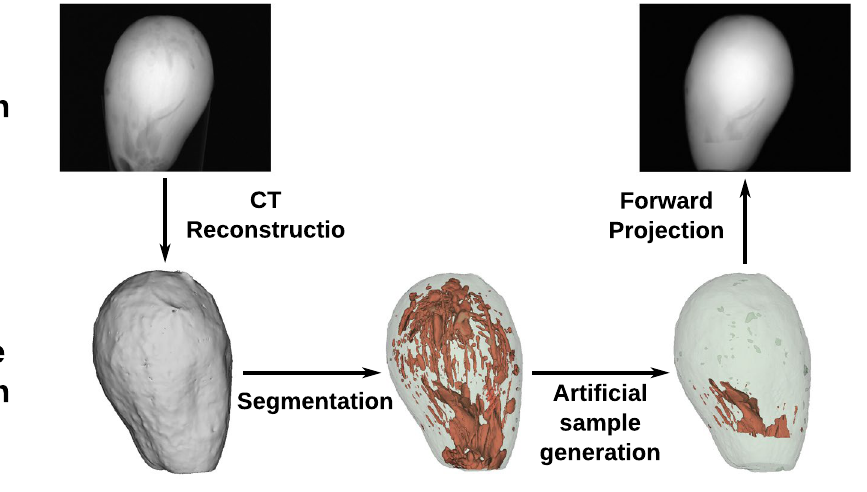
Figure 1. Proposed approach to data generation. All augmentations are performed on volume level and then forward projected to get an X-ray image.